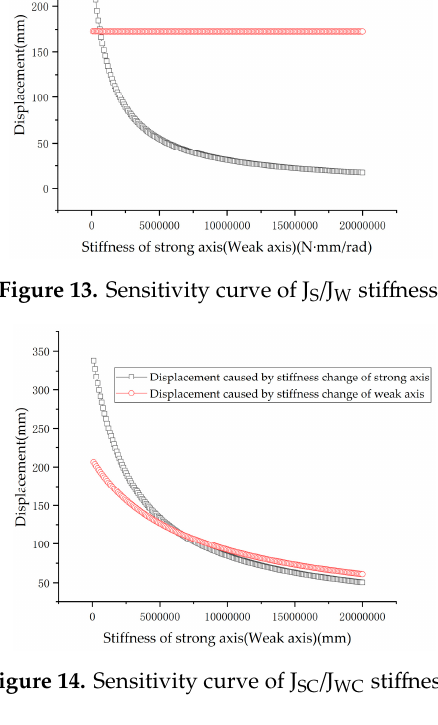
Figure 14. Sensitivity curve of J SC /J WC stiffness.